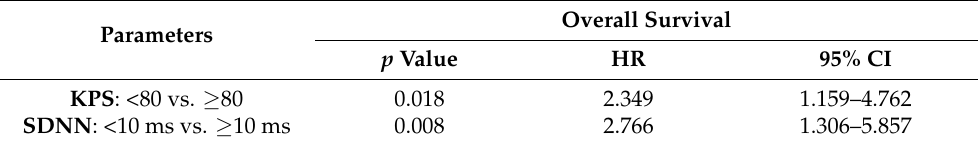
Figure 2. Survival curves stratified by prognostic factors ( A ) KPS, ( B ) SDNN. For multivariate analysis, a KPS of 80 ( p = 0.018; HR = 2.349, CI = 1.159–4.762) and an SDNN of 10 ms ( p = 0.008; HR = 2.766, CI = 1.306–5.857) were confirmed as independent OS prognostic factors (Table 4). Factors other than the KPS and SDNN did not meet statistical significance. Table 4. Multivariate analysis on overall